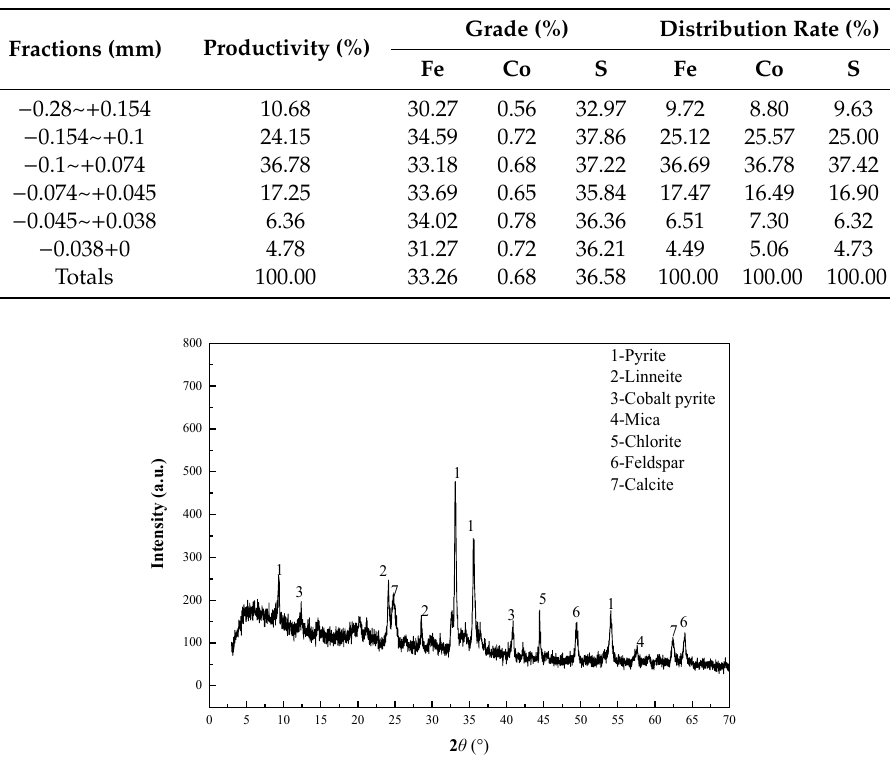
Table 4. Grain-sized analysis of Co-bearing sulfur concentrate.